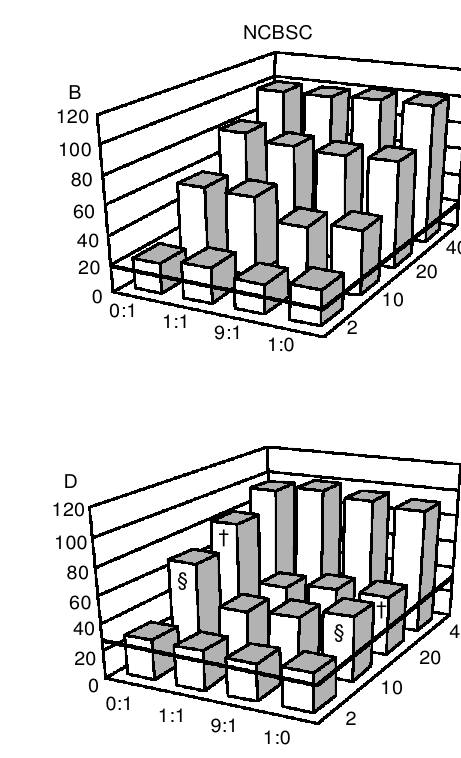
FIG. 4. Comparison between the inhibitory effect of PI and SLPI on 24 pmol NE and the detachment of adherent cells from endothelial matrix and epithelial matrix. The solid line represents NE alone while the bars represent NE in the presence of inhibitor. = signi® cantly enhanced inhibition of the action of NE on type II cell adherence to endothelial matrix by SLPI compared with PI; inhibitor level 20 pmol, P , 0.01; † = signi® cantly enhanced inhibition of the action of NE on epithelial cell adherence to epithelial matrix by SLPI compared with PI; inhibitor level 20 pmol, P , 0.001; § = signi® cantly enhanced inhibition of the action of NE on NCBSC adherence to epithelial matrix by SLPI compared with PI; inhibitor level 10 pmol, P ,